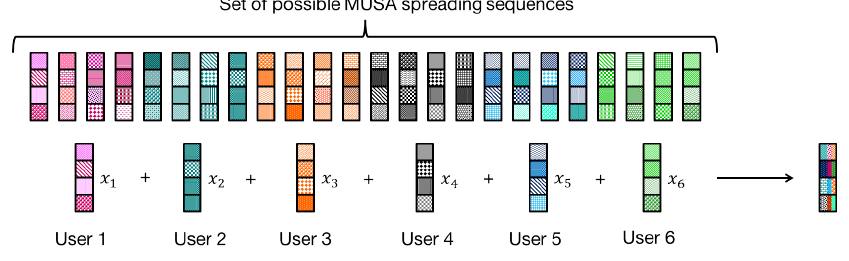
Figure 1. MUSA scheme system for J = 6 and K =